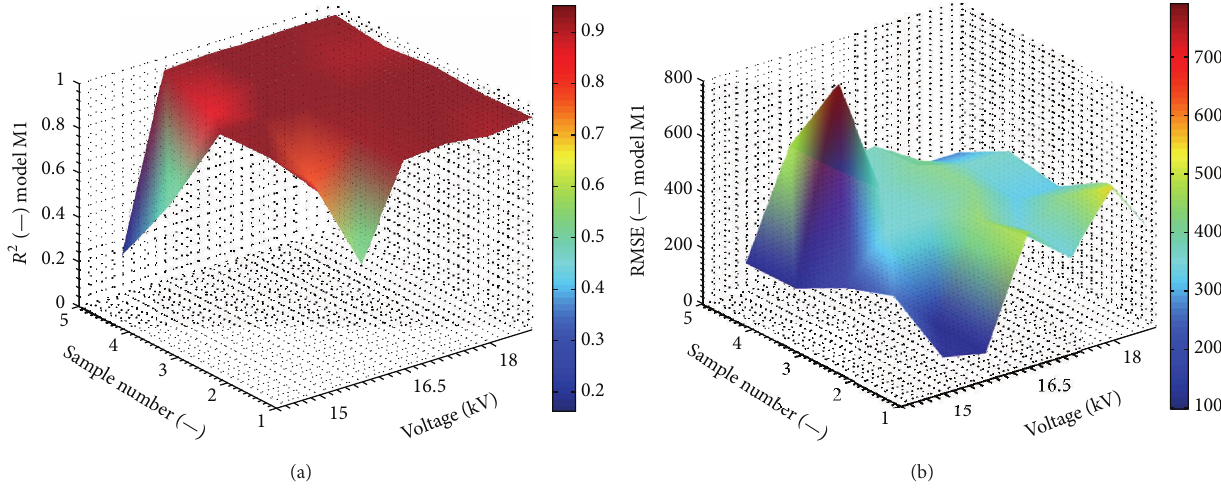
Figure 8: Comparison of values of 𝑅 2 (a) and RMSE (b) coefficients obtained by the regression of the model M1 for all the recorded signals.